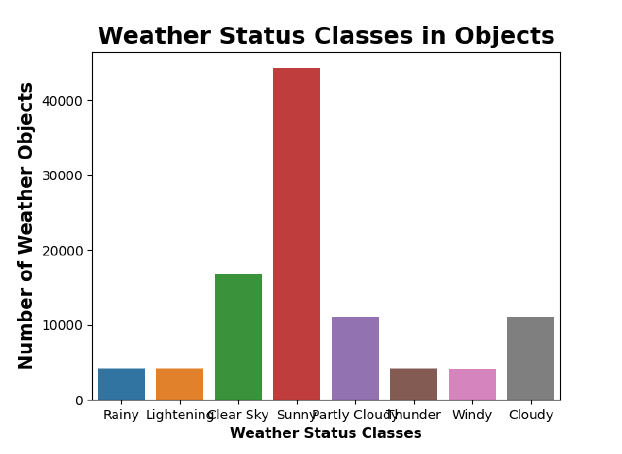
Figure 11. Weather Status Types.